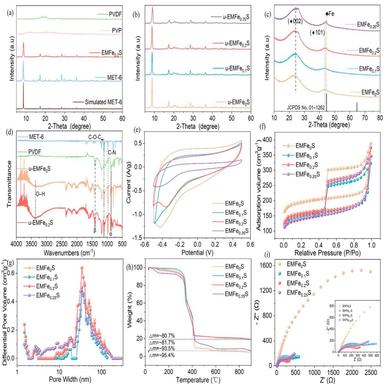
The XRD patterns analysis of PVDF, PVP, MET-6 and u-EMFe0S (a), different u-EMFexS (b) and (c) different EMFexS; (d) the FTIR analysis of MET-6, PVDF, EMFe0S and EMFe0.2S; (e) TGA of four catalysts under an N2 atmosphere; (f) Nitrogen adsorption− desorption isotherms and (g) pore size distribution of four catalysts; (h) and (i) the CV and EIS curves of four catalysts, respectively.